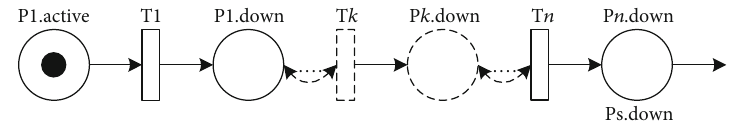
Figure 2: The model of the warm standby system.